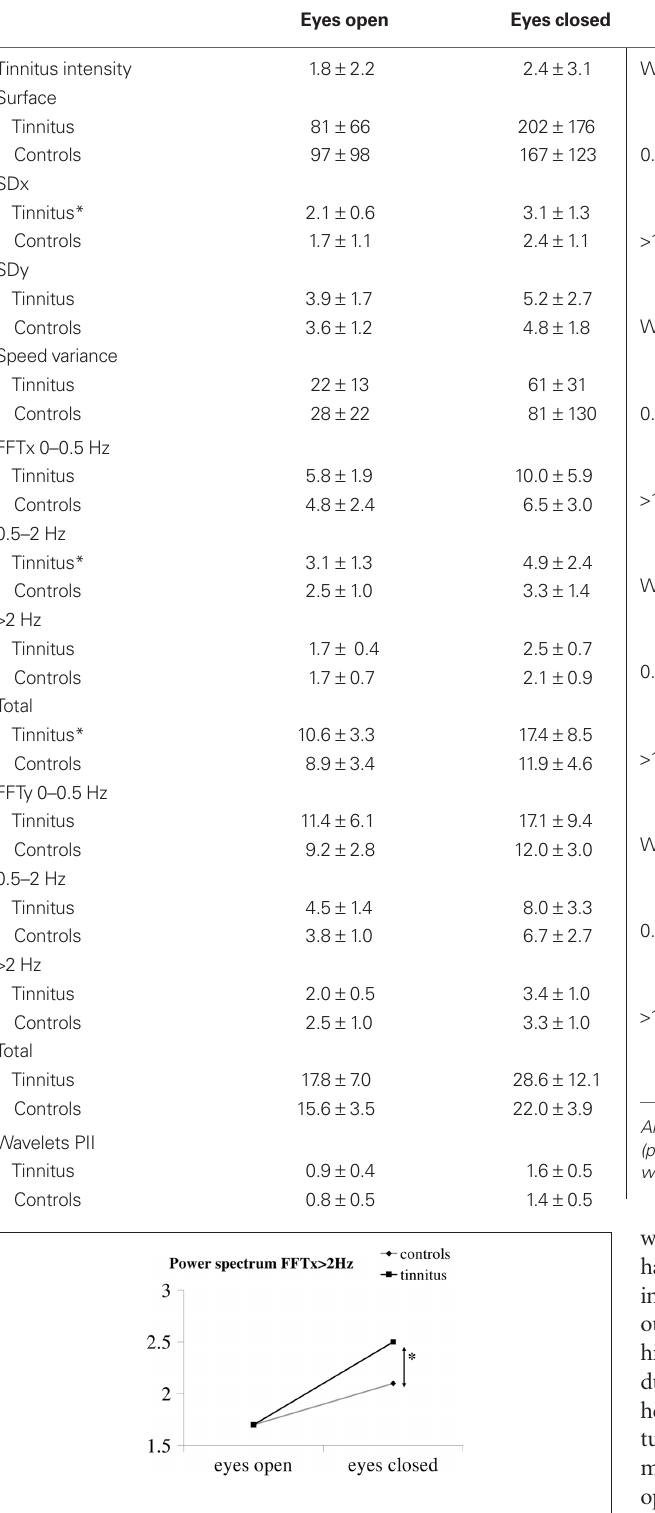
FiGuRE 1 | interaction between group and vision condition. The power index for high frequencies of the medio-lateral body sway is only significantly higher in tinnitus patients under the eyes closed